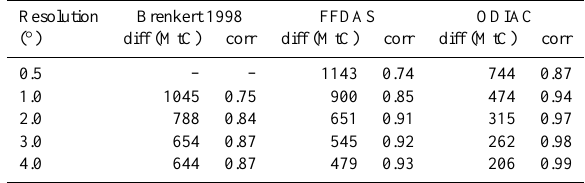
Table 3. Comparison, across the US, of our ODIAC map and the Vulcan map. “Brenkert 1998” (the first column) is a population- based map constructed at 1 ◦ resolution (Brenkert, 1998). “FFDAS” (the second column) was based on nightlight data corrected by pop- ulation data (Rayner et al., 2010). The total emissions of the par- ticipating inventories were scaled with respect to the Vulcan total emission level for the year 2002, and the sum of the absolute of the Vulcan values minus the map being compared (diff) and spatial correlations with the Vulcan map (corr) were calculated at different spatial aggregation levels (0.5 ◦ –4 ◦ ) (Rayner et al., 2010). Values are given in units of Megatonne